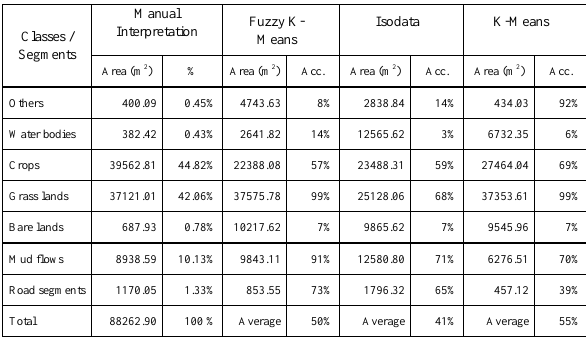
Table 5. Feature extraction with Seed file data Fuzzy K-Means classification showed relatively better feature